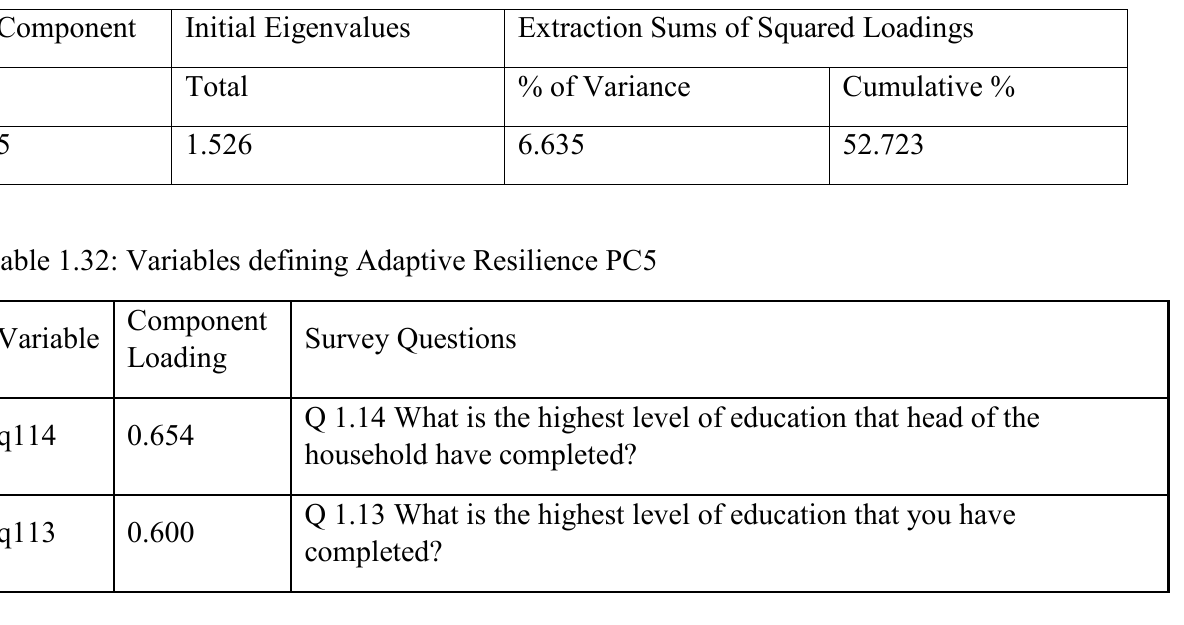
Table 1.31: Variance explained for Adaptive Resilience PC5